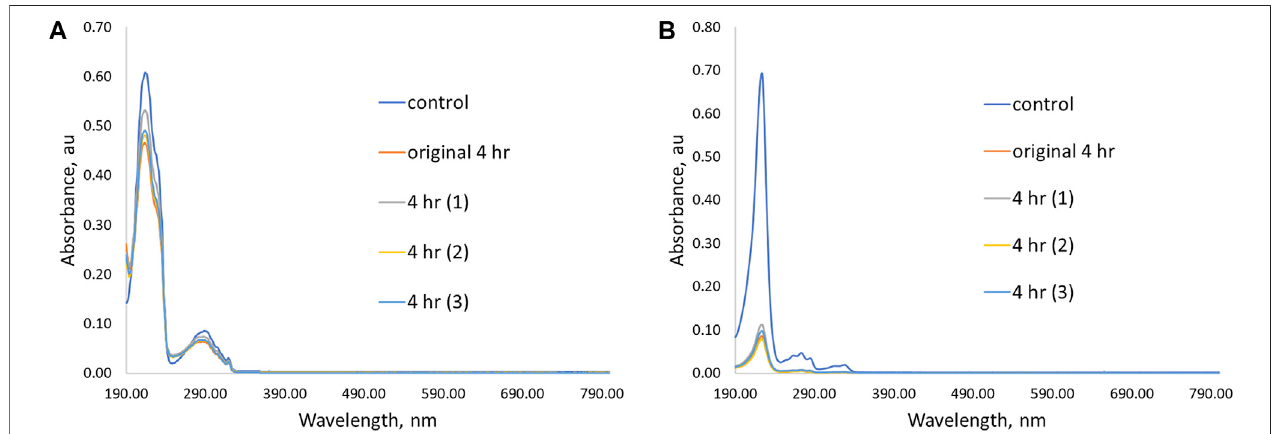
FIGURE 6 | Decreases in concentrations of contaminants following binding experiments for crosslinked polymers.